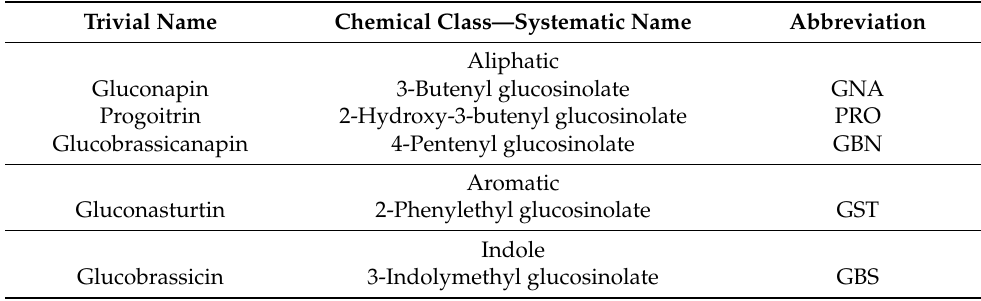
Figure 2. Glucosinolate percentage in analysed B. rapa cultivars. Table 1. Trivial name, chemical class, systematic name and abbreviations of major glucosinolates found in leave samples of Brassica rapa